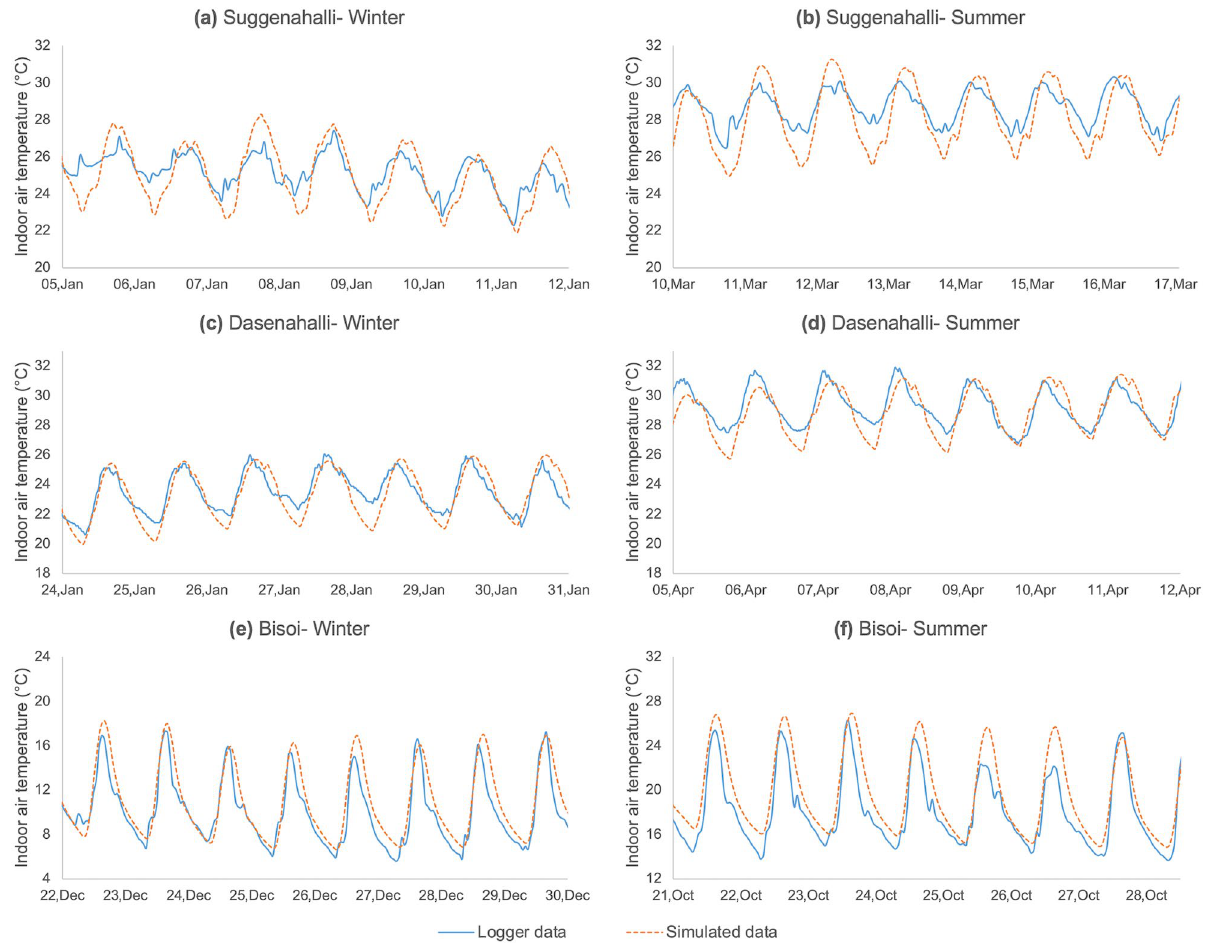
Figure 4. Comparison of simulated and measured temperature data for a representative week-long period in Summer and Winter for the dwellings studied in the three settlements: Figure shows comparison of measured and simulated hourly indoor air temperatures (in °C) for a representative week in winter and summer for the three dwellings to understand how the simulation model has been able to represent the actual indoor operating conditions prevailing in the dwellings. Solid blue line shows the real-time temperature measurements recorded by the loggers, while the dotted orange line shows the simulated data. The simulation models tend to closely imitate real-time operating conditions, suggesting that the models are representative enough to be used for studying the behaviour of the original